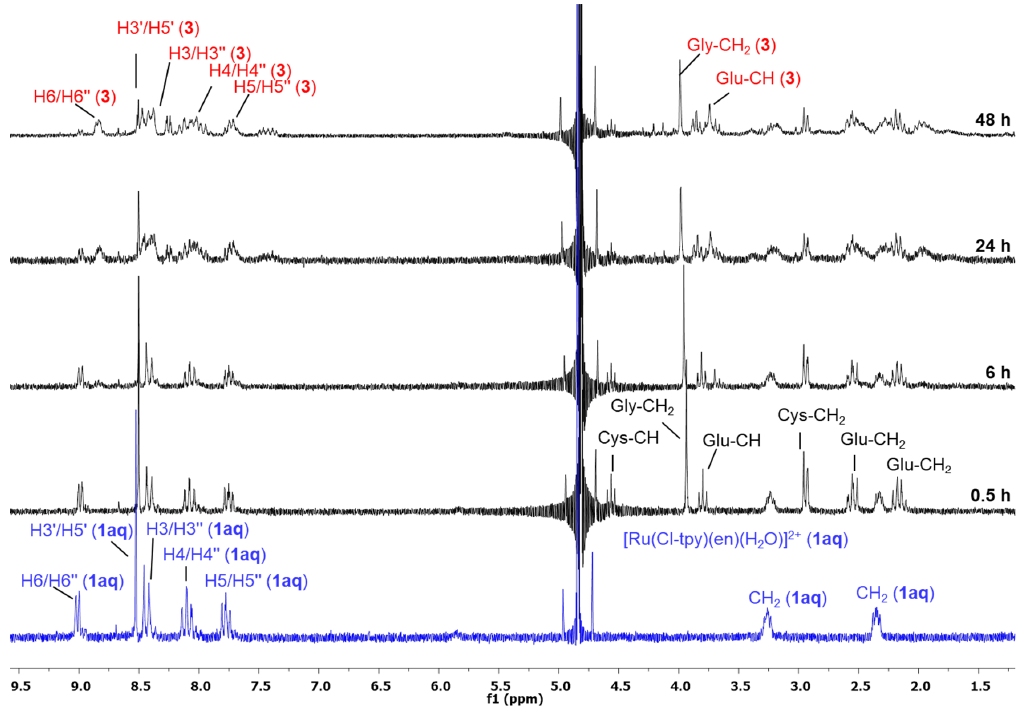
Figure 2. 1 H NMR spectrum of [Ru(Cl-tpy)(en)(Cl] + ( Ru-1 , 10 mM) 10 min after dissolution in D 2 O and at various time intervals after addition of GSH.